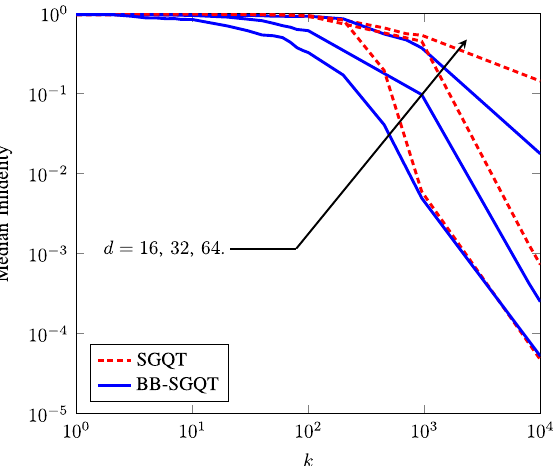
Figure 2. Average infidelity plots for qubits d = 16,32,64 obtained from 100 randomly generated qubits using Haar measurement. Blue lines show the median infidelity plots for our algorithm, and red dotted lines show the same plots for SGQT. Here, we choose N = 10 4 number of measurements per